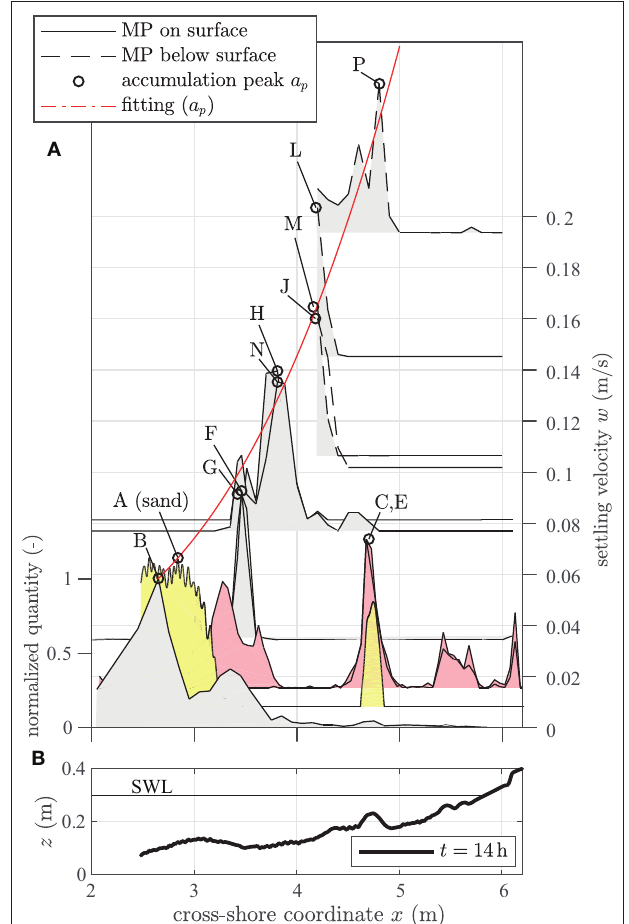
FIGURE 9 | (A) Shoreline-orthogonal distribution of normalized MP quantities on (black solid contour) and below (black dashed contour) the bed profile sorted by corresponding settling velocity. (B) Bed profile elevation for t (black bold line) and still water line (black